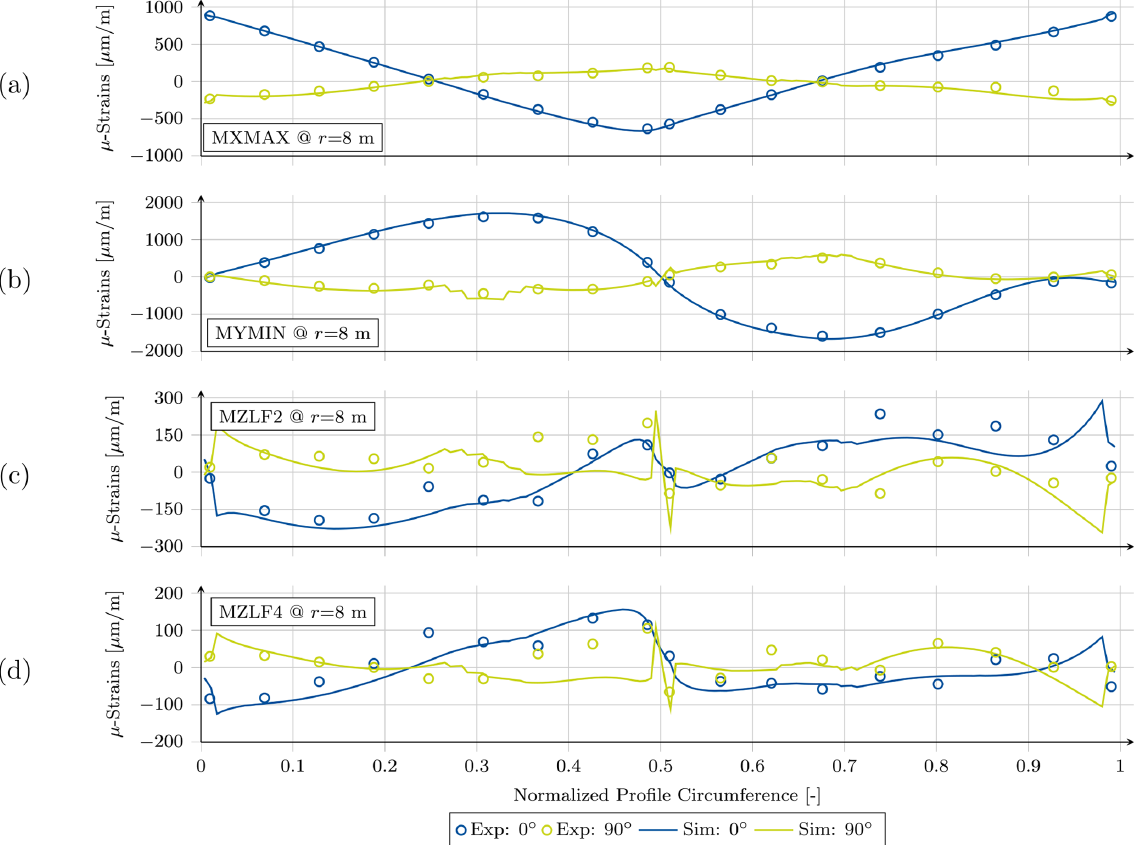
Figure B4. Spanwise and crosswise strains of the simulation and the test, plotted against the normalized profile circumference of the cross section at r = 8m for the (a) MXMAX, (b) MYMIN, (c) MZLF2, and (d) MZLF4 load